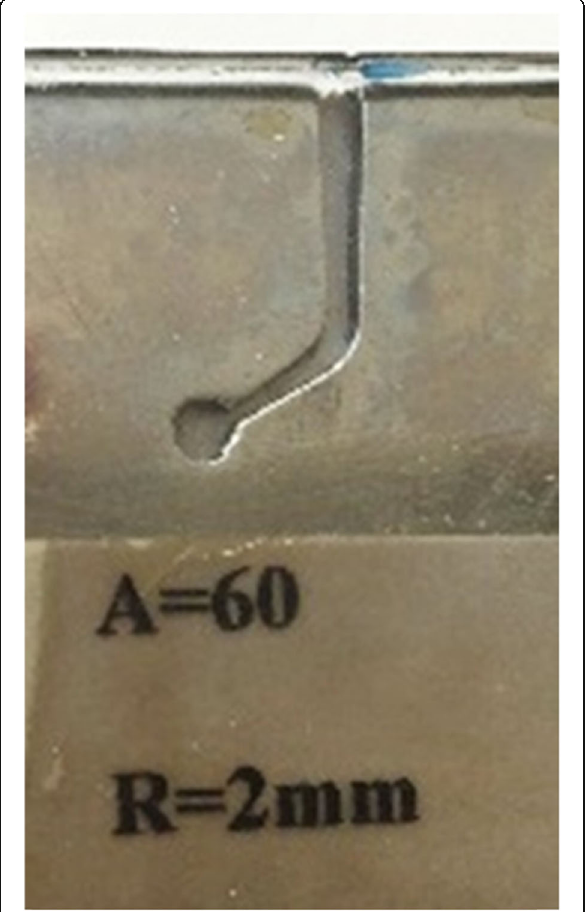
Fig. 1 Custom made cyclic fatigue testing